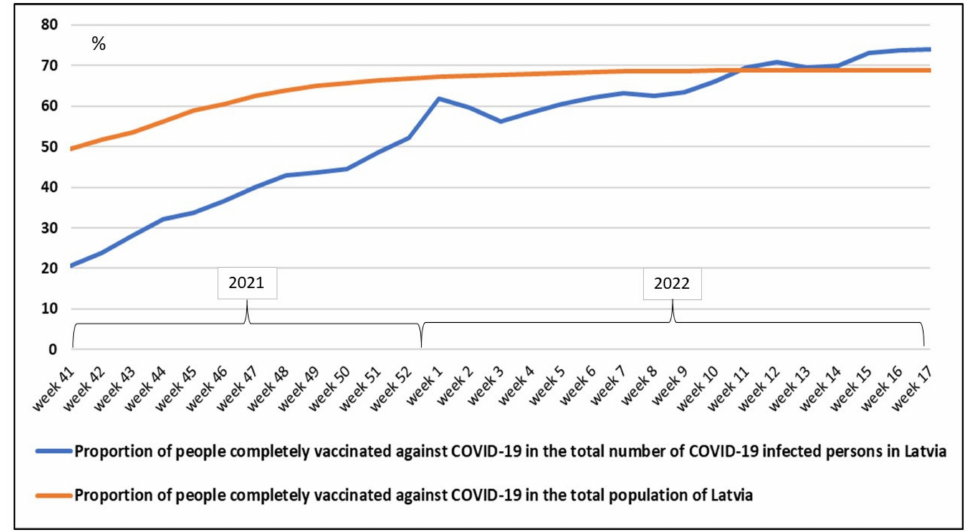
Figure 2. Proportion of people completely vaccinated against COVID-19 in the total population of Latvia, and proportion of people completely vaccinated against COVID-19 in the total number of COVID-19-infected persons in Latvia, in a period from week 41 of 2021 until week 17 of 2022 (constructed by the authors, using the statistical data of the competent authorities of Latvia